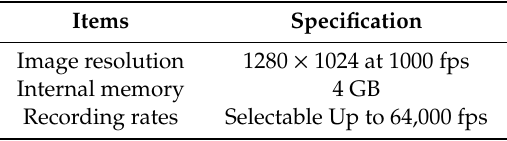
Table 5. Specification of the camera.